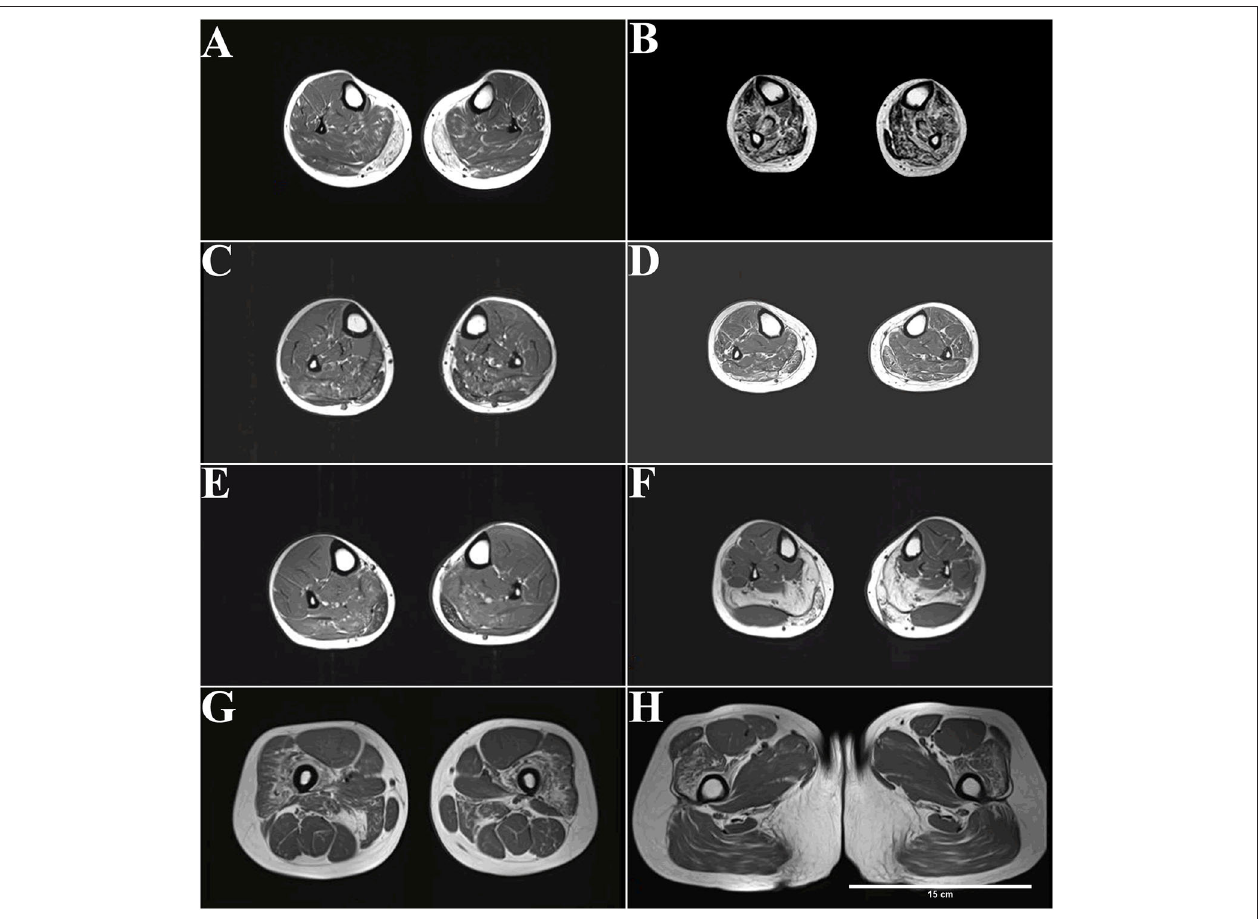
FIGURE 2 | MRI (T1-weighted) of patients with dysferlinopathy shows fatty infiltration of muscle. (A) The peroneus, extensor digitorum longus, and extensor halluces longus muscles were involved in patient 1 with disease duration of 4 years. (B) More advanced stages show an involvement of the tibialis anterior in patient 2 with disease duration of 20 years. (C,D) The peroneus, extensor digitorum longus, and extensor halluces longus muscles were also involved in patient 3 (C) and patient 4 (D) with disease duration of 3 years. (E,F) Only the gastrocnemius and soleus muscles were affected in patient 6 (E) and patient 7 (F) with disease duration of 1–2 years. (G,H) Increased signal can be observed in the quadriceps femoris and adductor magnus muscle in patient